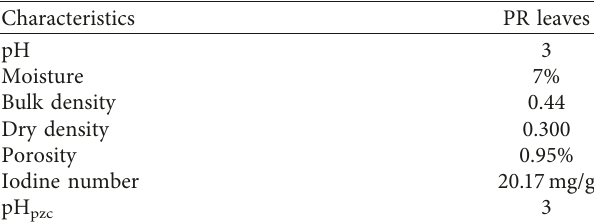
Table 2: Analysis of leaf